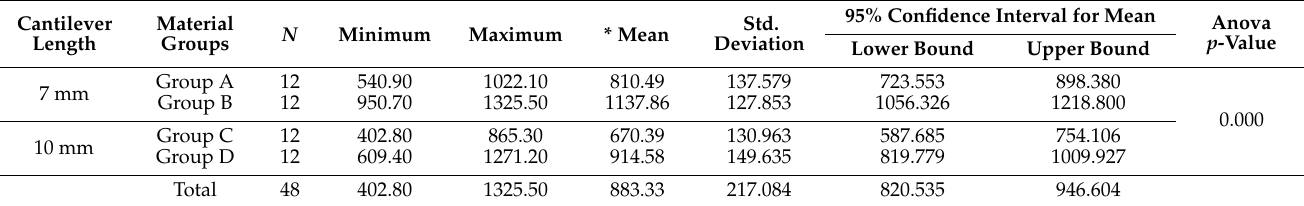
Table 1. Descriptive statistics with mean, standard deviation, and ANOVA results of fracture load for the test groups ( N = 48). Cantilever Length